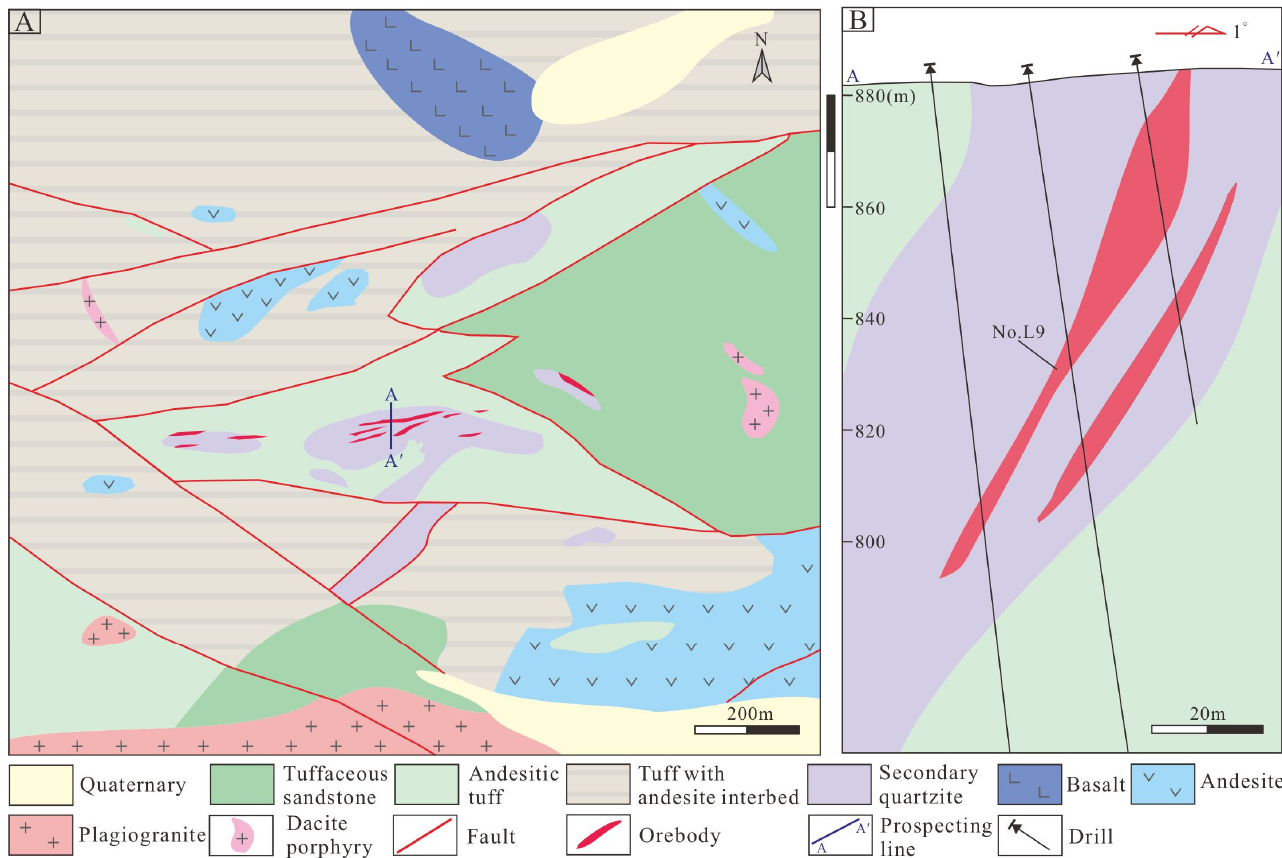
Figure 2. ( A ) Geological map of the Harla gold deposit; ( B ) geological section of No. 6 exploration line across the Harla gold deposit (modified according to Chen and Gong) [8].